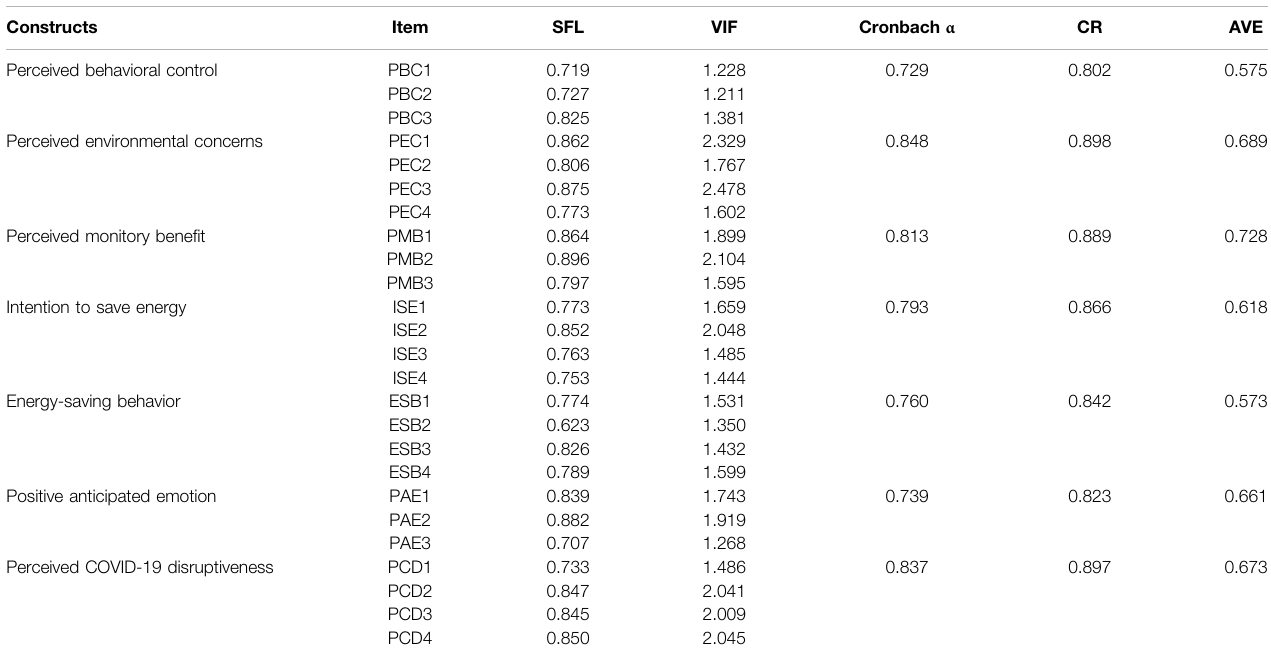
TABLE 4 | Factor loadings of measurements